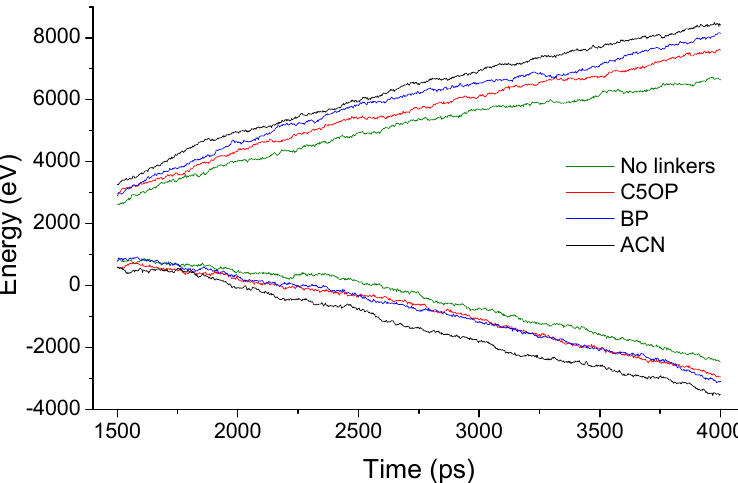
Figure 5. Energy flowing through thermostats as a function of the time for PDMS-surrounded graphene interfaces. Four simulations are taken as examples for three different linkers (C5OP, BP, and ACN) and a linkerless model (No linkers). Table 1. Averaged heat flux for different linkers in PDMS. Average value, thermostat variation, replica variation and linker gain as the ratio of linker heat flux over linkerless heat flux value.